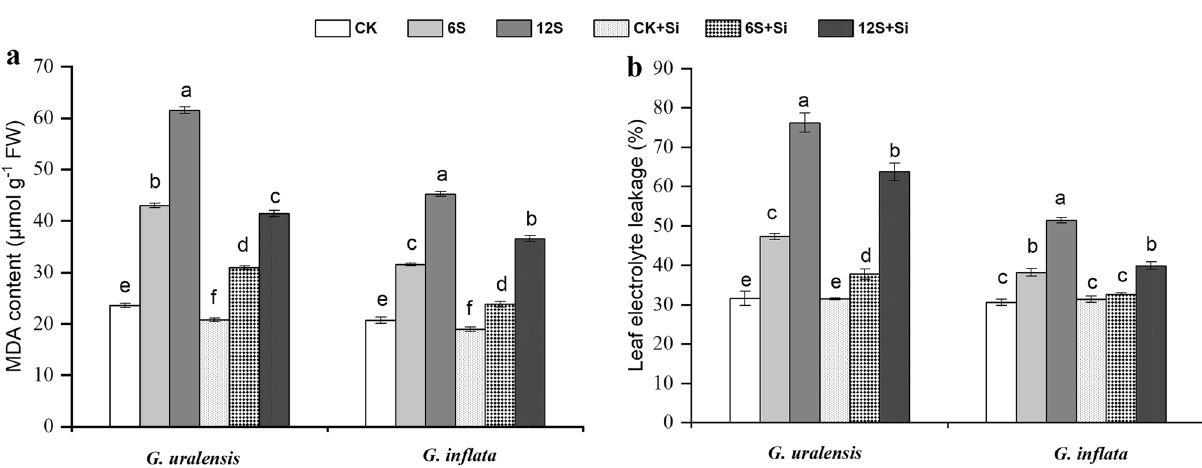
Figure 6. Effects of salinity and Si on malondialdehyde content (MDA, a ) and leaf electrolyte leakage (LEL, b ) in the two liquorice species. Data are presented as the mean ± SE (n = 3). Different letters indicate significant differences between the values for one index for the same liquorice species under different treatments (P <